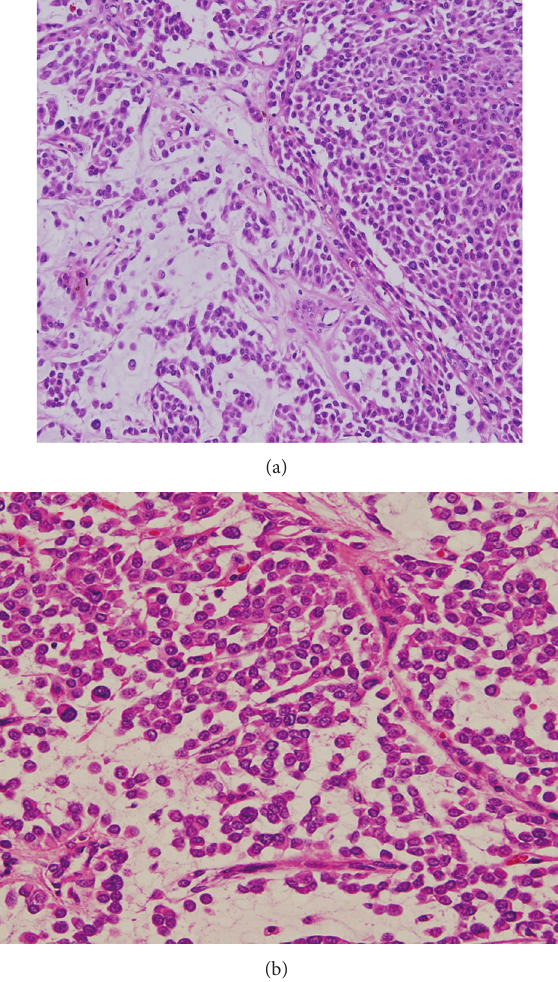
Figure 2: Histopathological examination of nasolabially excised mass. Tumor had a benign nature mostly, with an expansive growing pattern and a few pleomorphic, atypical cells, and rare mitotic activity. In addition, generalized lymph vascular invasion was present ((a) HE, × 100; (b) HE, ×